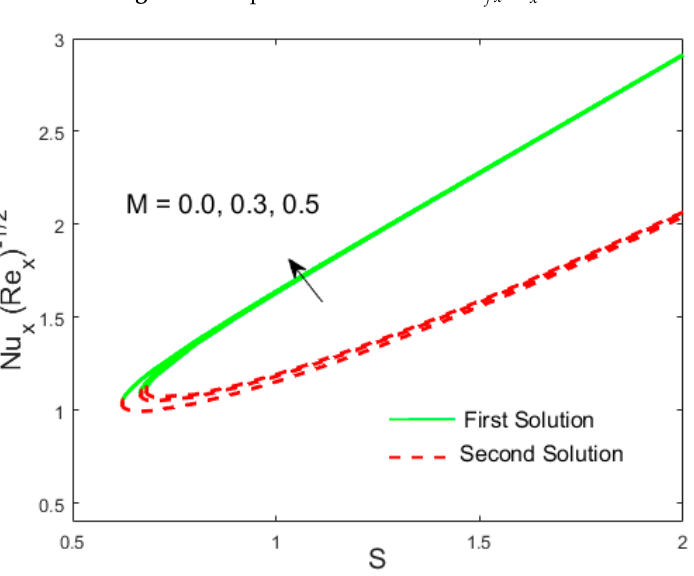
Figure 17. Impact of M versus S on Nu x Re